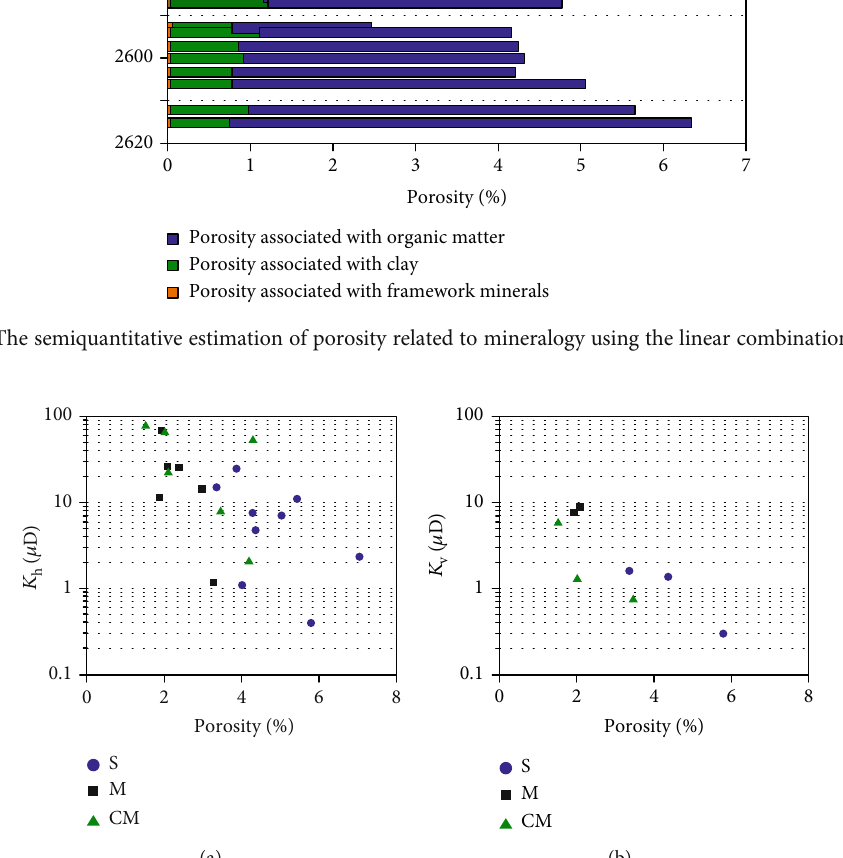
h ) was measured parallel to